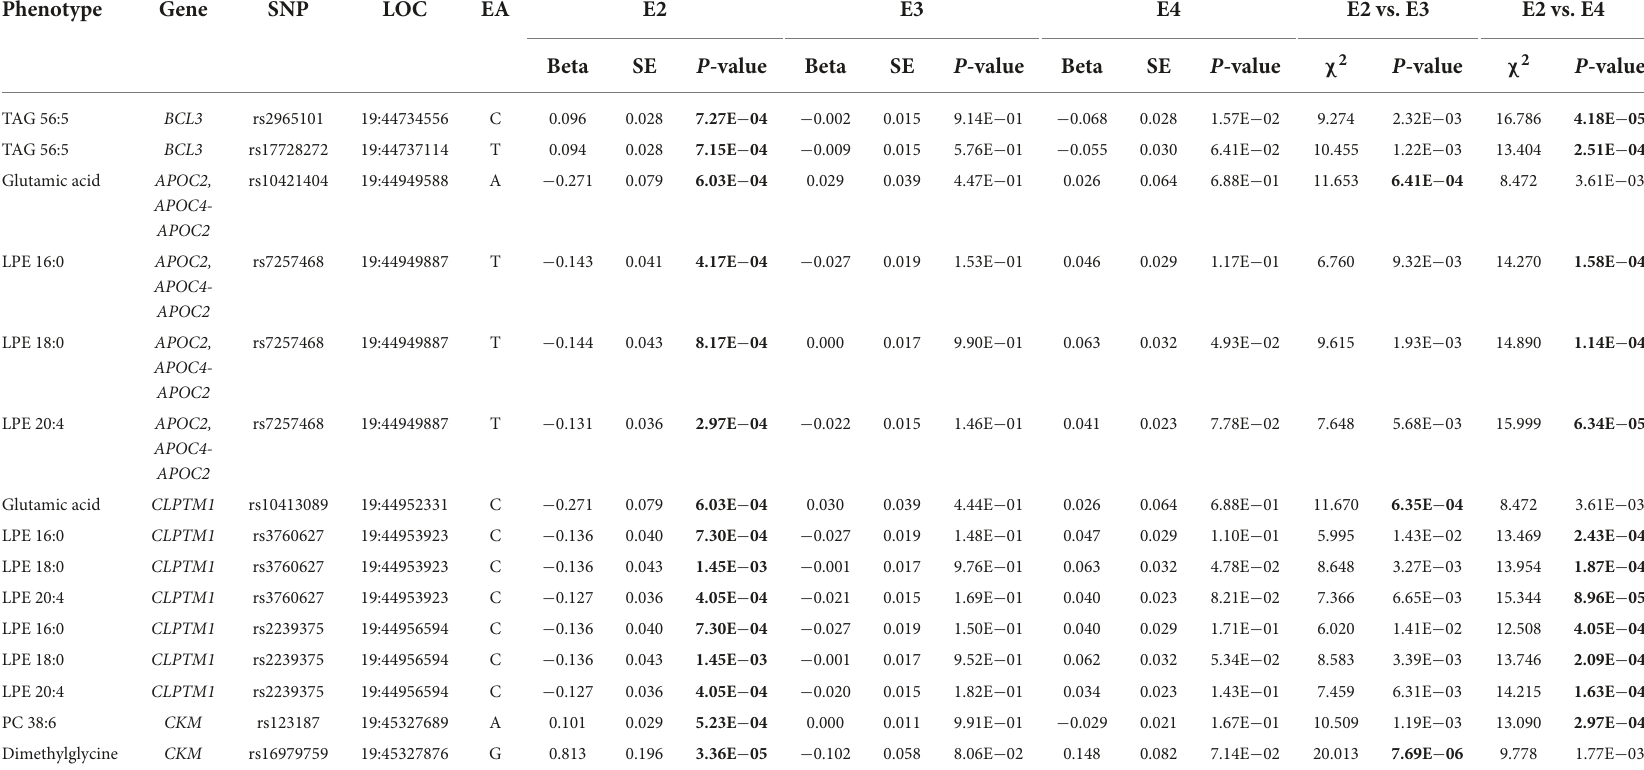
TABLE 2 Group-specific associations identified in the E2